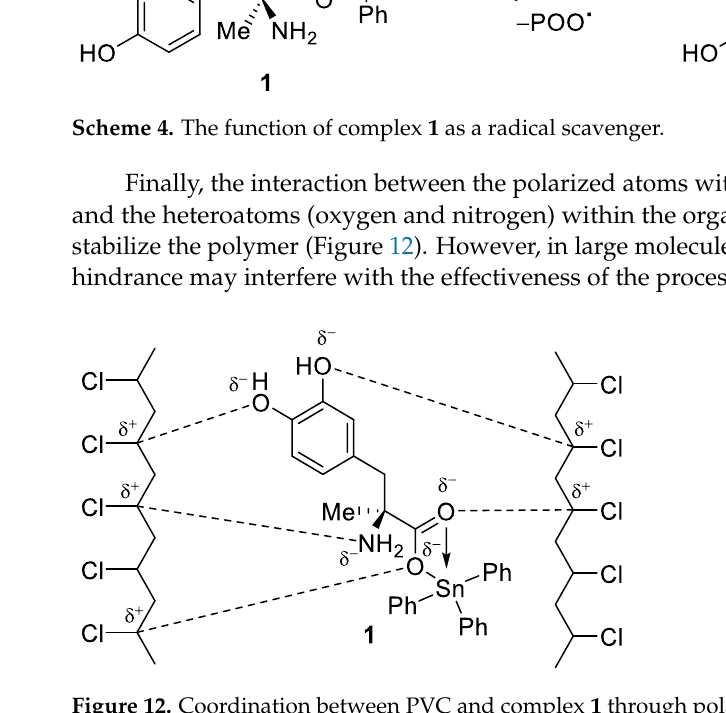
Figure 12. Coordination between PVC and complex 1 through polarized bonds.